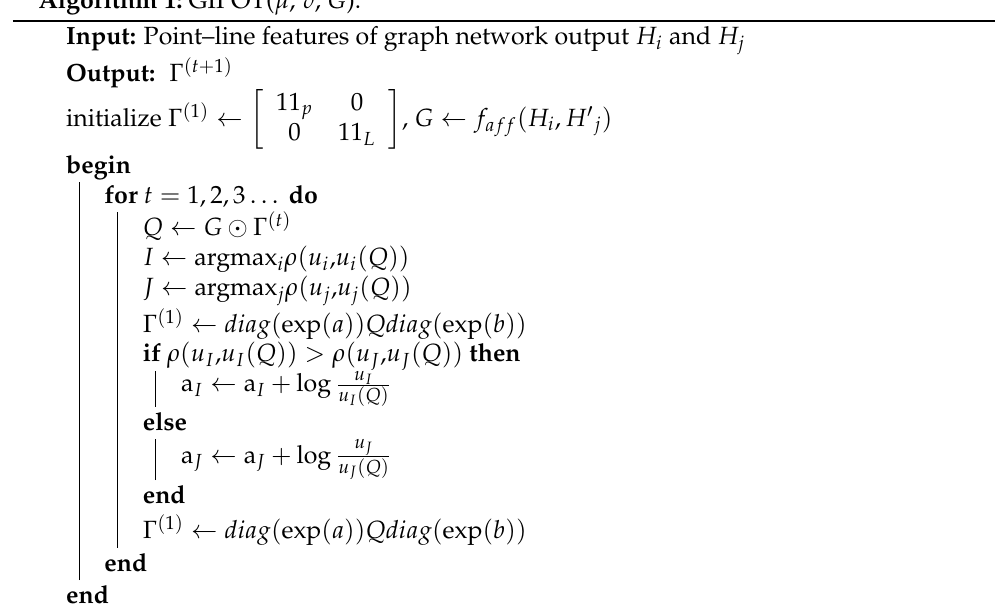
Algorithm 1: GIPOT( µ , v , G